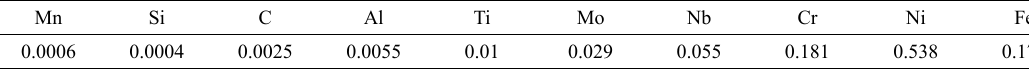
Table 1. Inconel 718 chemical composition